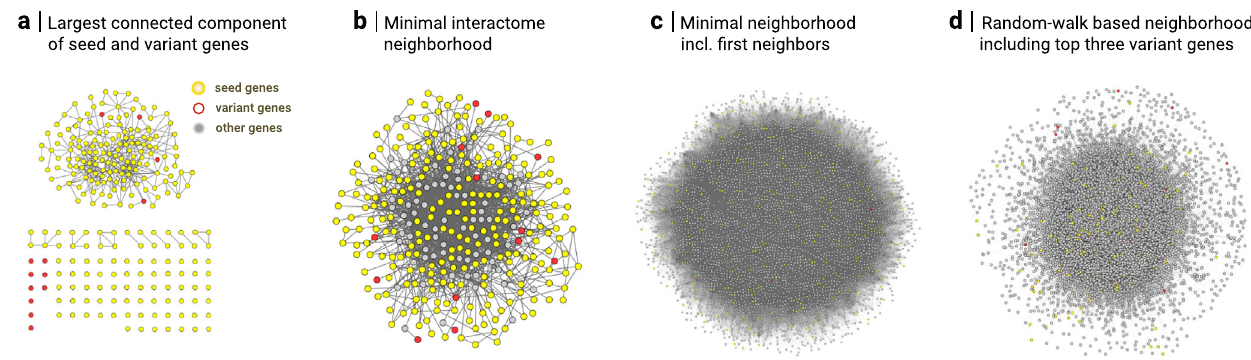
Fig. 4 Static 2D visualization of the seed and variant genes in the interactome. a The 247 seed and 13 variant genes are scattered across several disconnected subnetworks in the interactome. The largest connected component contains 157 genes (153 seed and 4 variant genes). b Using a Steiner tree approach 60 , we can identify a minimal set of linker genes for integrating all seed and variant genes into a single connected component. The resulting subnetwork consists of N = 334 nodes and M = 1387 links. c Expansion of the subnetwork in ( b ) with all fi rst neighbors results in N = 10,915 nodes and M = 261,853 links. d Random walk-based interactome neighborhood around the seed genes obtained by including all genes that are ranked above the top three variant genes ( N = 4052; M = 118,218). All network visualizations were created using the